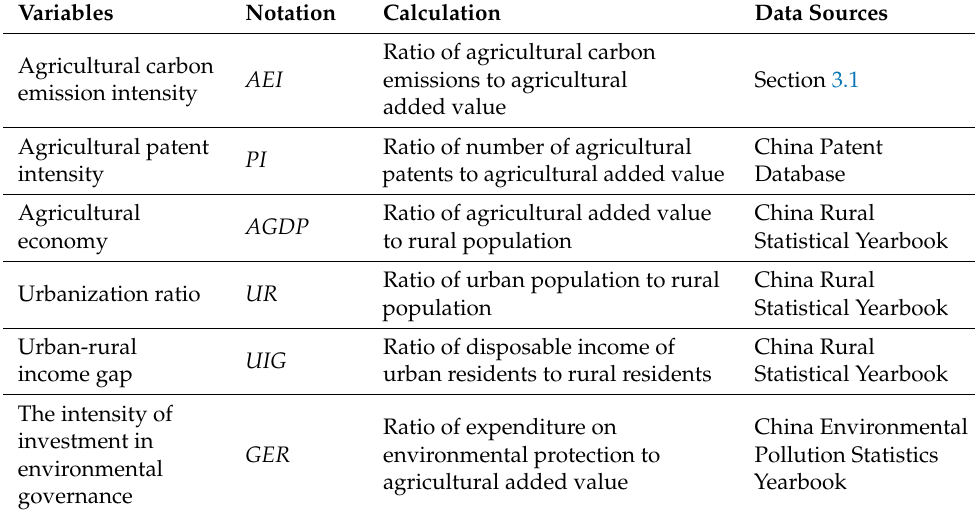
Table 2. SDM variables used in the